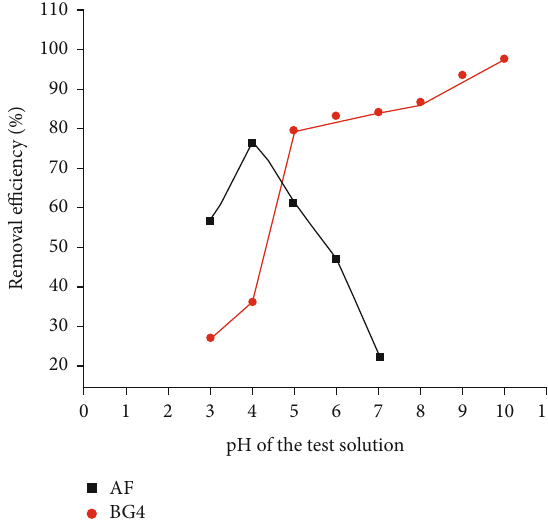
Figure 5: E ff ect of pH on the dye removal e ffi ciency of